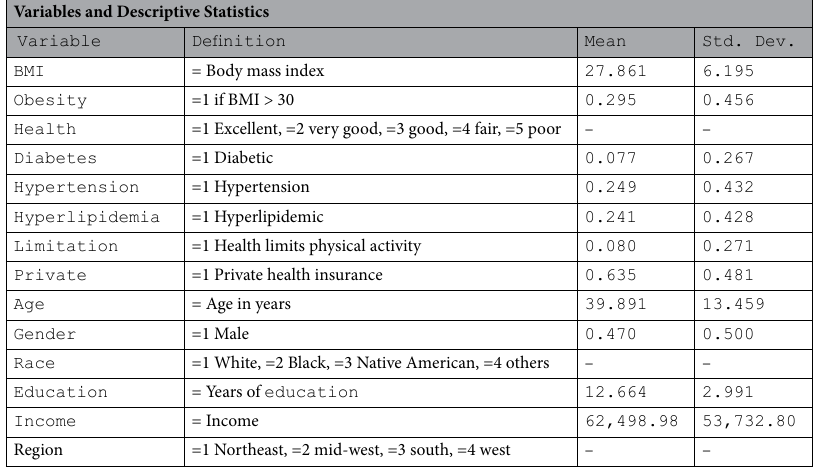
Table 2. Variables and results of the descriptive statistics. Data were obtained from the Medical Expenditure Panel Survey (MEPS) for USA. N = 18,592